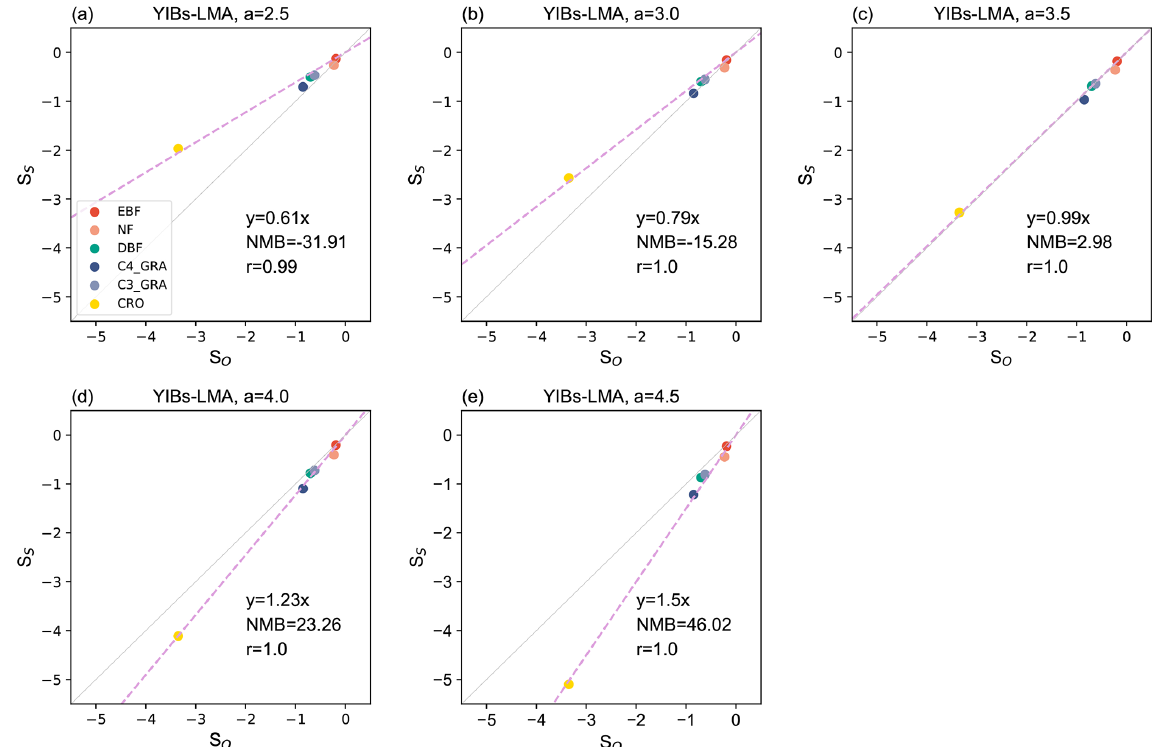
Figure 3. Comparison between S O (% per mmolm − 2 ) and S S (% per mmolm − 2 ) for the YIBs-LMA experiment. Five tests from the YIBs-LMA experiment all adopt x = 0 . 019nmolg − 1 s − 1 and gridded LMA from M2018 but with varied parameter a from (a) 2.5 to (e) 4.5nmol − 1 sg. S O values are from Table S1. S S values are derived as the slope between R GPP and POD y . The linear regression (dashed lines), 1 : 1 fitting (light-grey lines), normalized mean bias (NMB), and correlation coefficient ( r ) between S S and S O for varied PFTs are shown on each panel. The S S and S O of CRO are derived using POD y = 6 , while other PFTs use POD y = 1 . The YIBs-LMA experiment is described in Table